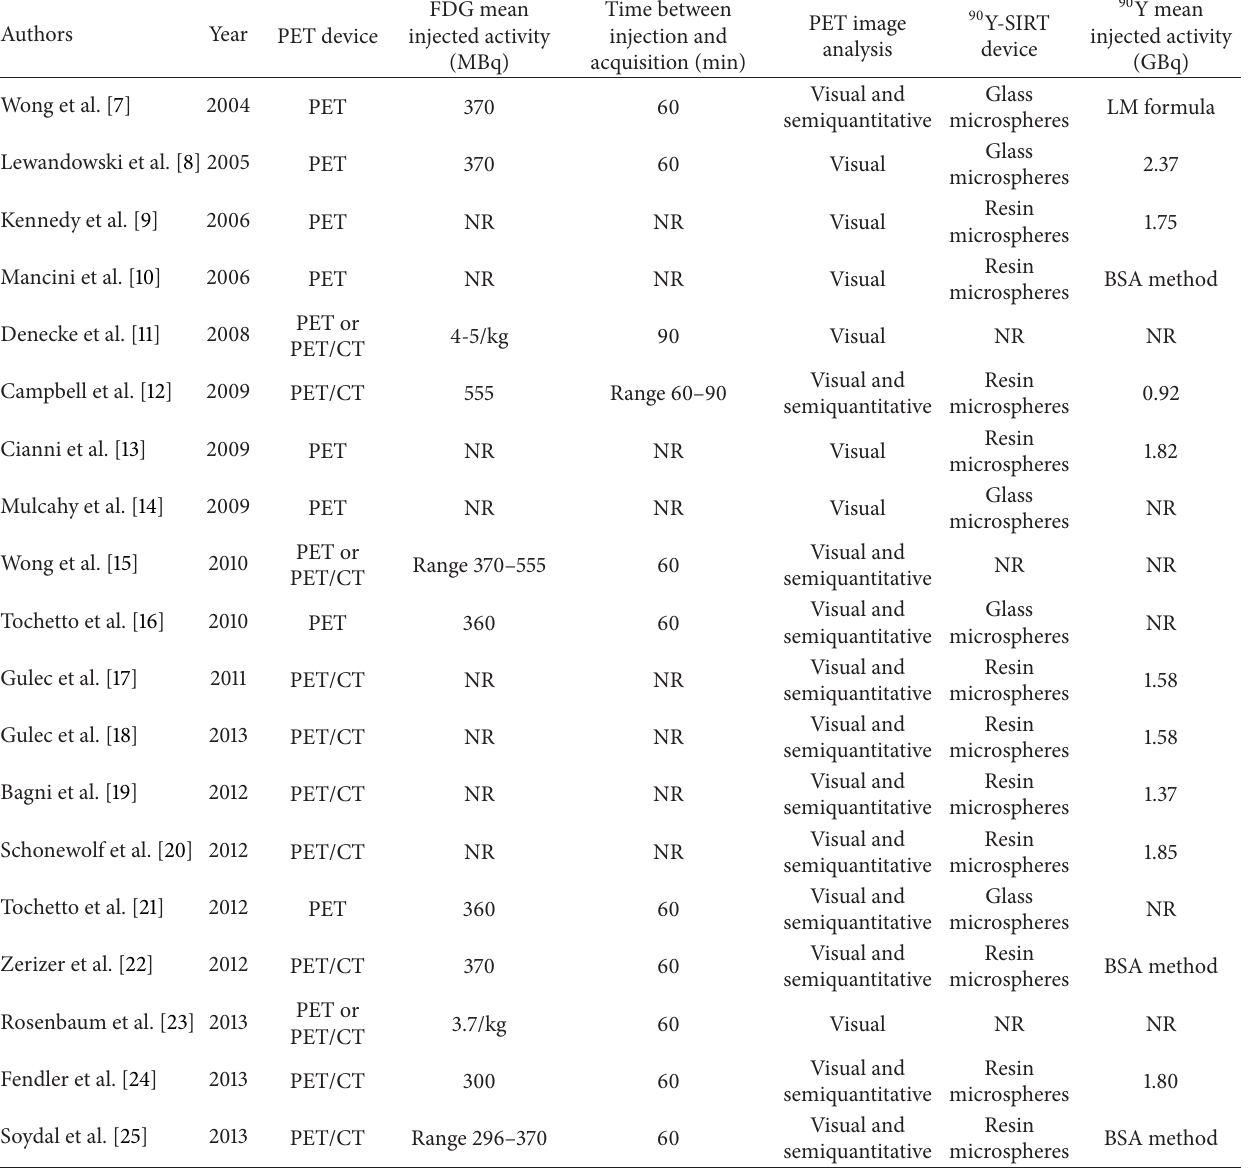
Table 2: Technical characteristics of the included